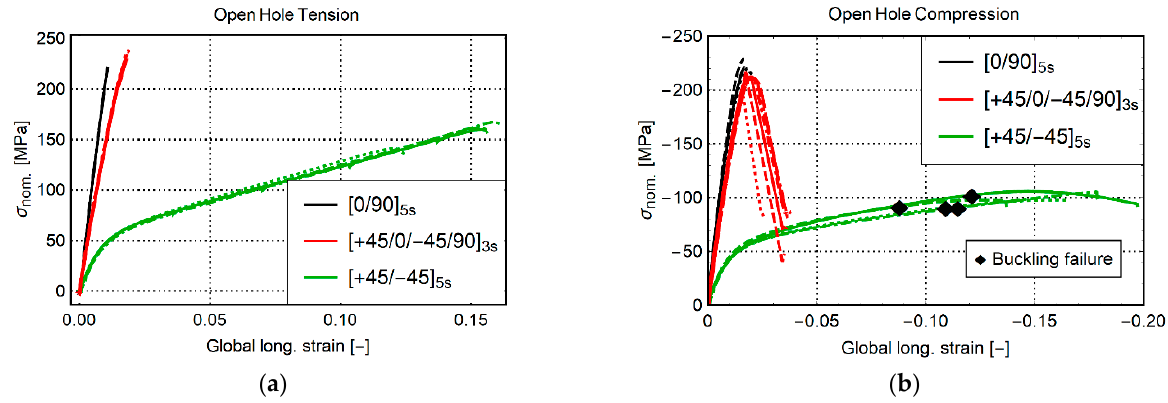
Figure 3. Nominal stress vs. global strain of samples subjected to monotonic loading until failure. ( a ) OHT, ( b ) OHC.